Question: In a single sentence, describe what this figure presents.
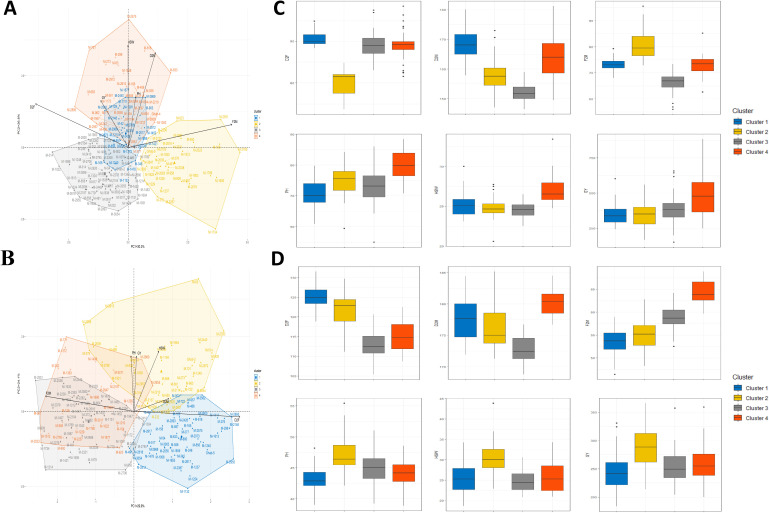
Answer: Principal component analysis (PCA) of agronomic traits and genotype clustering under Marchouch and Terbol environments. PCA biplots based on the first two principal components are shown for Marchouch (A) and Terbol (B) , illustrating the relationships among agronomic traits and genotype distribution patterns. Boxplots showing the distribution of agronomic traits across the identified PCA-derived clusters are presented for Marchouch (C) and Terbol (D) .